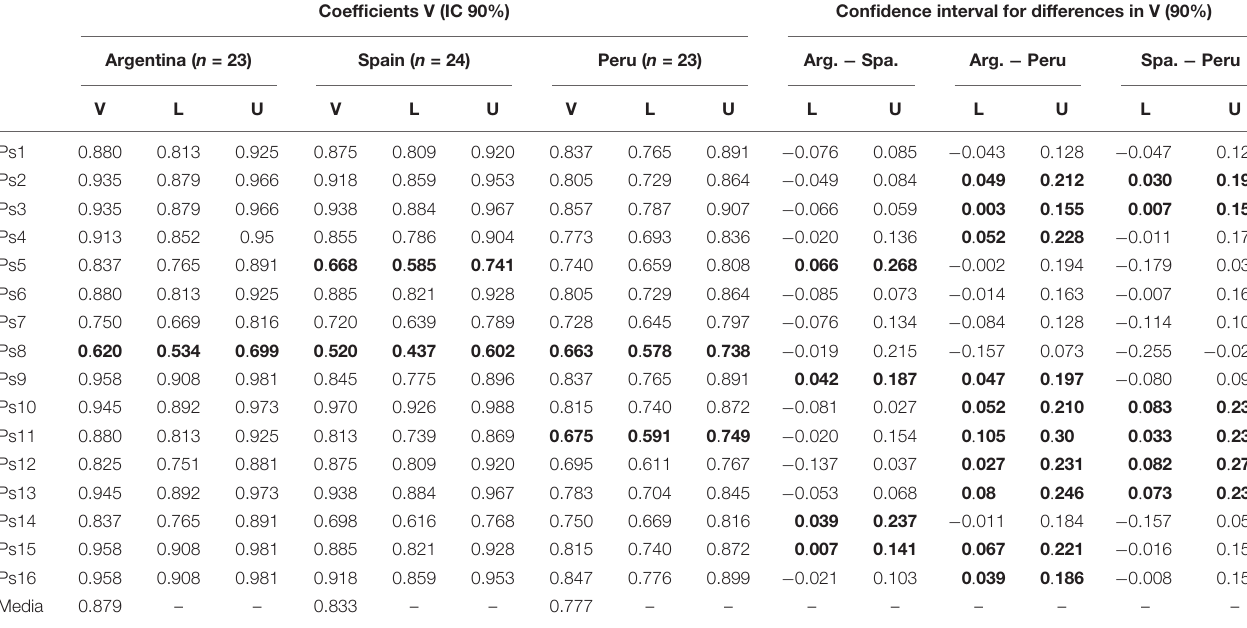
TABLE 1 | Coefficients V: clarity of content between participants (Argentina, Spain, and